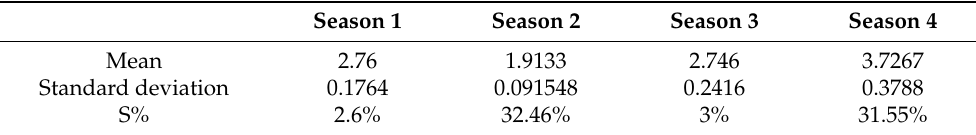
Table 7. Statistical comparison of Rayleigh shape parameter for seasons 1, 2, 3 and